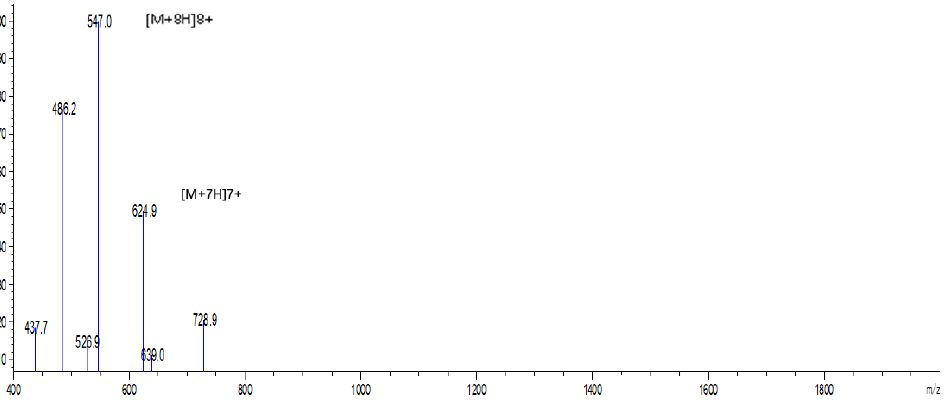
Figure 2. Electrospray ionization-mass spectrometry (ESI-MS) analysis of purified EF-1. Table 1. Minimum inhibitory concentrations (MICs) and minimum bactericidal concentrations (MBCs) of synthesized Plantaricin EF (PlnEF) and recombinant EF-1 against indicator bacterial strains. Indicator